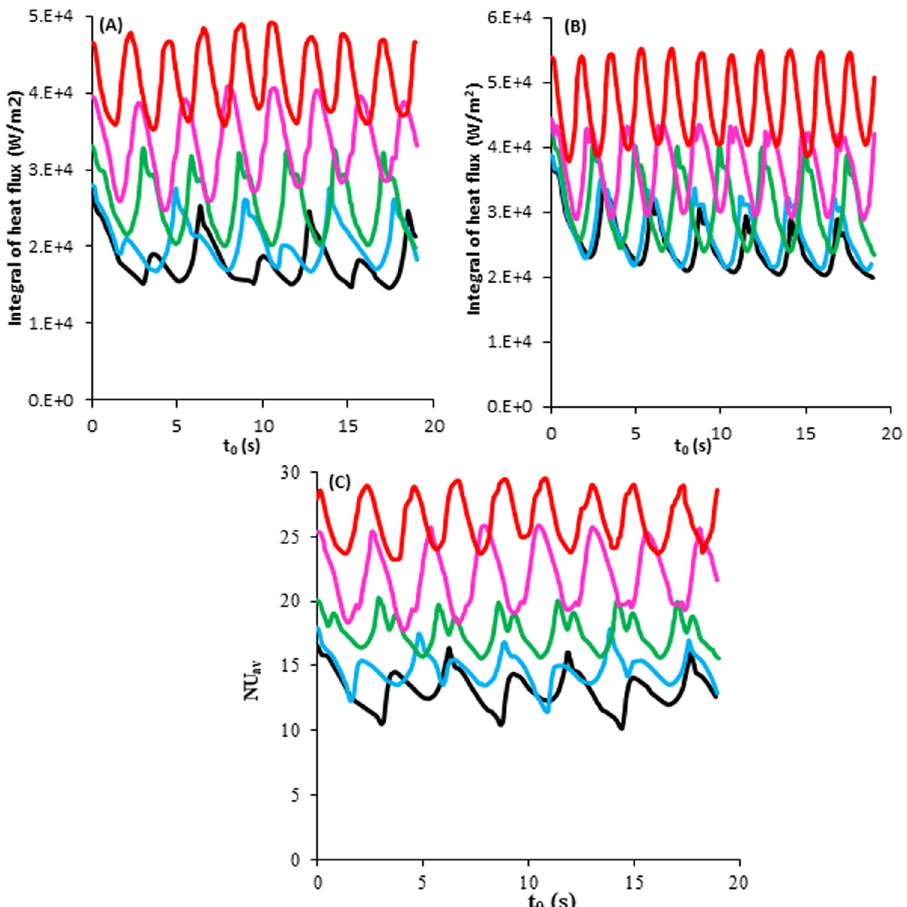
Fig. 6 Heat fl ux and Nusselt number passing through the superheat at different operating conditions. Integration of heat fl ux at different voltage passing through the superheat with contact angle of 50° and temperature of ( A ) 7°C and ( B ) 8.5°C. ( C ) Nusselt number at different voltage passing through the superheat with the temperature of 7°C and contact angle of 50°. 0V (